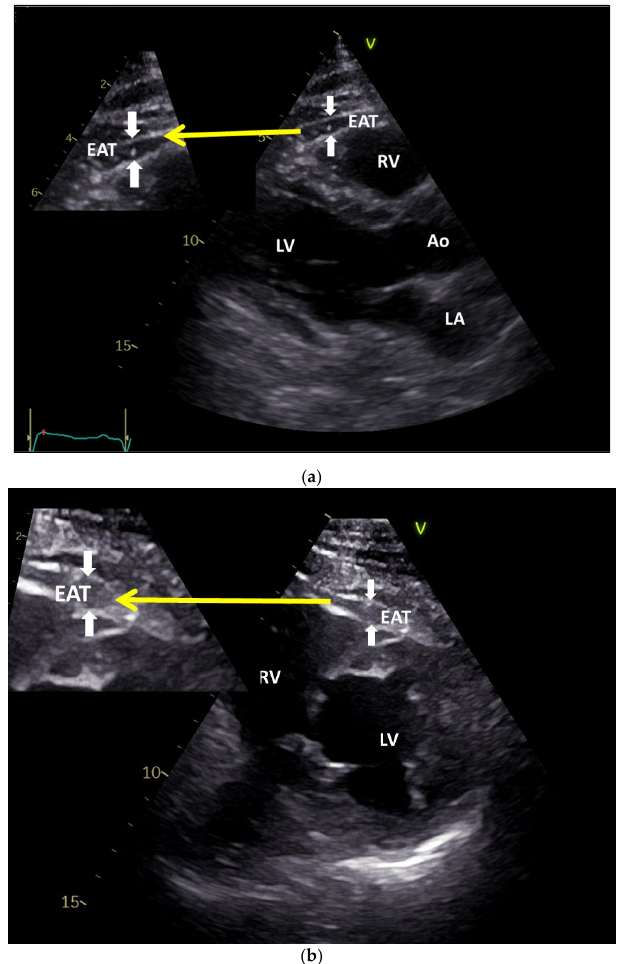
Figure 3. Epicardial fat by transthoracic echocardiography. ( a ). Epicardial fat thickness at parasternal long axis (the distance from outer side of myocardium to pericardium). ( b ). Epicardial fat by transthoracic echocardiography. Epicardial fat thickness at parasternal short axis (the distance from outer side of myocardium to pericardium). EAT—Epicardial Adipose Tissue; RV—Right Ventricle; LV—Left Ventricle; Ao—Aorta; LA—Left Atrium. White arrows pointing towards the EAT; Yellow arrow pointing towards the magnified view of EAT. It has been shown that epicardial fat is a source of inflammatory mediators. During myocardial revascularization by aortocoronary bypass, epicardial fat tissue and subcuta- neous tissue were harvested in order to compare the expression of inflammatory media- tors. The presence of inflammatory cytokines (interleukin-1 β , interleukin-6, tumor